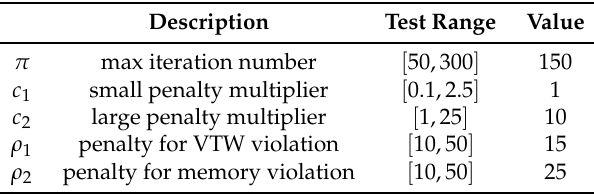
Table 1. Parameters for the ELSH